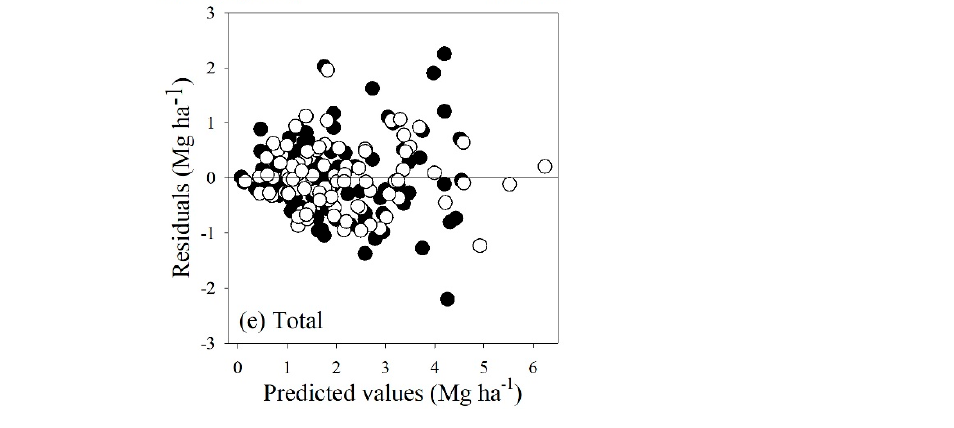
Figure 2. Evaluation of the biomass functions selected for ( a ) graminoids, ( b ) forbs, ( c ) ferns, ( d ) brambles, and ( e ) the sum of all growth habits (total) when using only cover (C, filled circle) or cover and height (C and H, open circle) for the pooled data set. Table 5. Summary of model evaluation statistics using 10-fold cross-validation for biomass estimations for each growth habit of early-seral vegetation growing in Western Oregon.